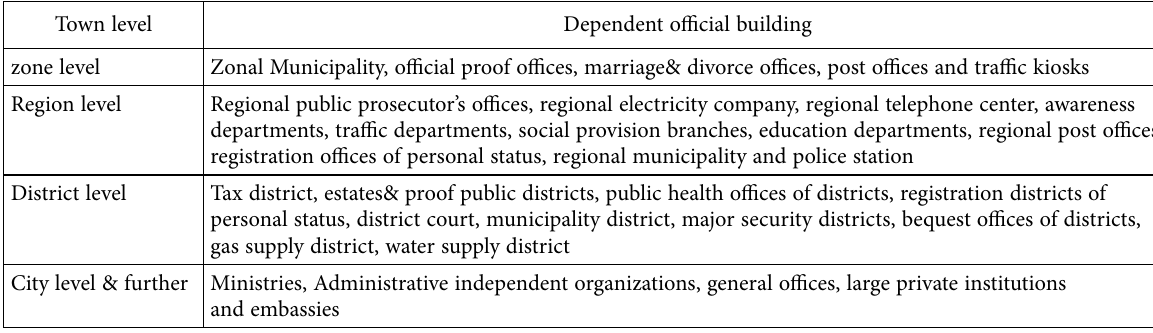
Table 1. Types of affiliated office buildings (Hoseini